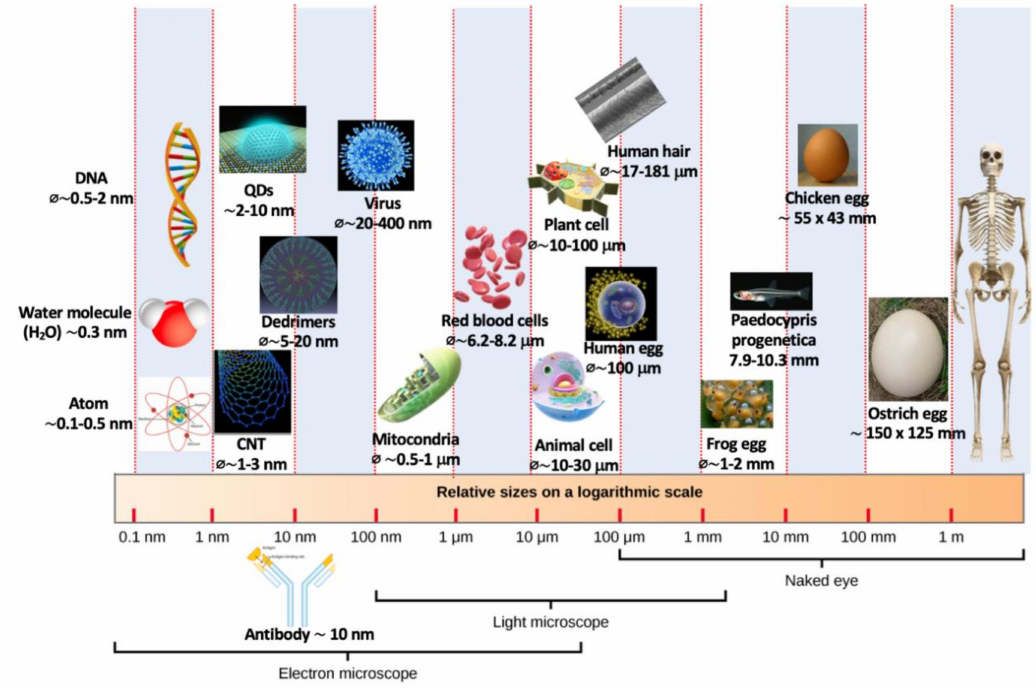
Figure 1. Materials scale. All the images in this figure were obtained from Wikimedia Commons. Adapted from